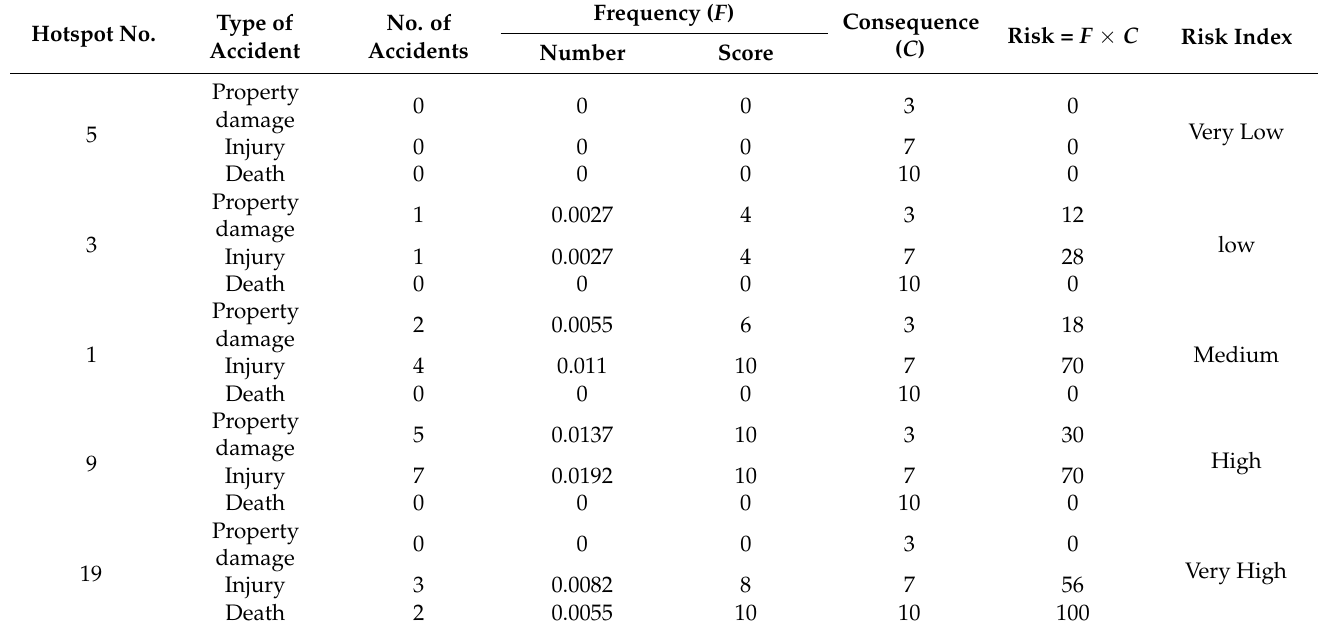
Table 4. Examples of five hotspots with different risk score for year 2017.